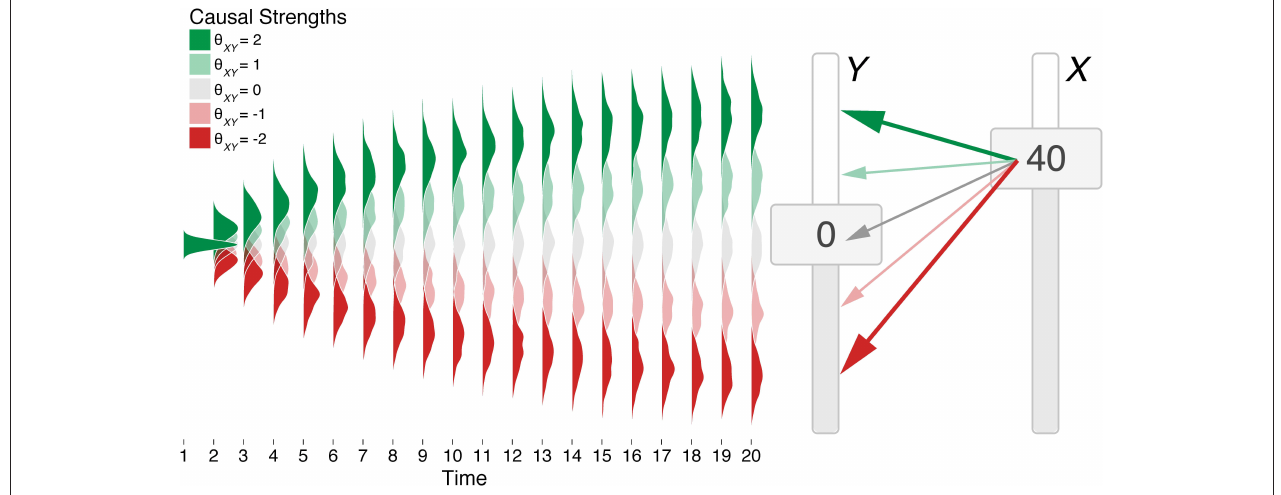
FIGURE 2 | Visualization of the impact of a single cause (slider X ) on a single effect (slider Y ) in an OU network with different causal strengths. Slider X is held to a value of 40 for 20 timepoints, leading slider Y to unfold over time to different values depending on the causal strength. Probability distributions are smoothed averages of 100 runs of the network given different causal “strengths” θ XY (colored shading) where ω = 0.1 and σ = 5.